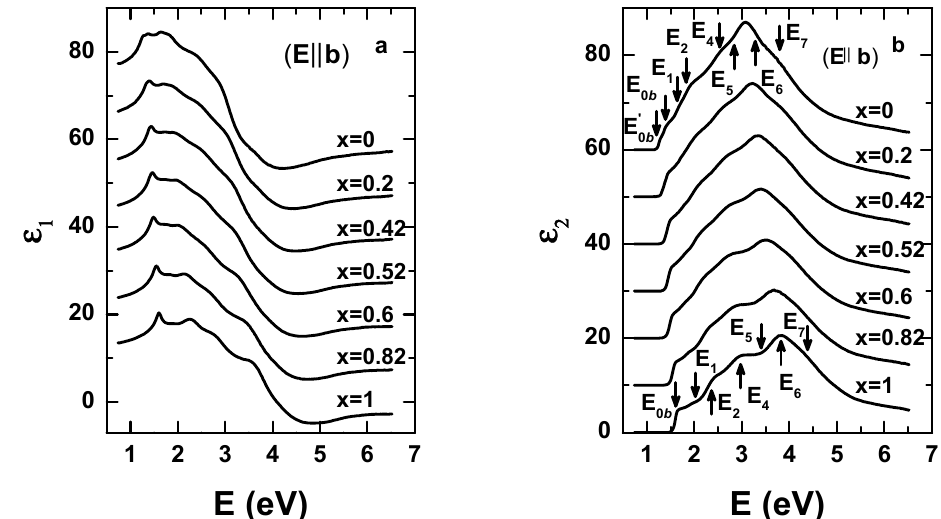
Figure 7. Real ( a ) and imaginary ( b ) parts of the dielectric functions of SnS x Se 1- x along the armchair direction. The spectra are shifted by increments of 10 from that at x = 1.